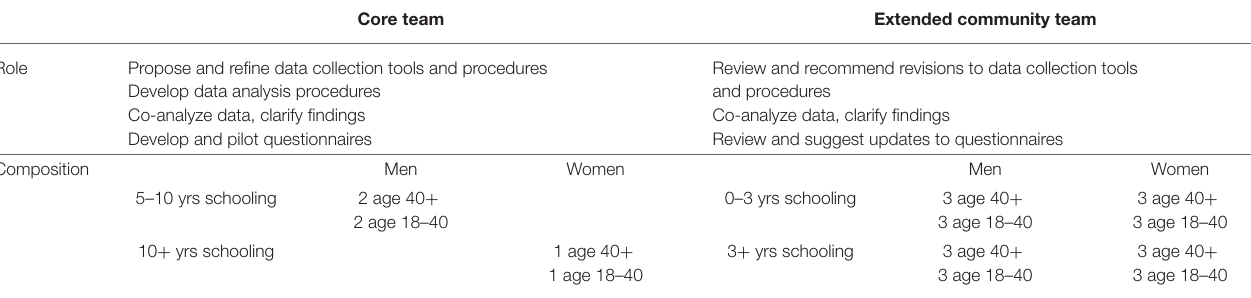
TABLE 1 | Research team composition and